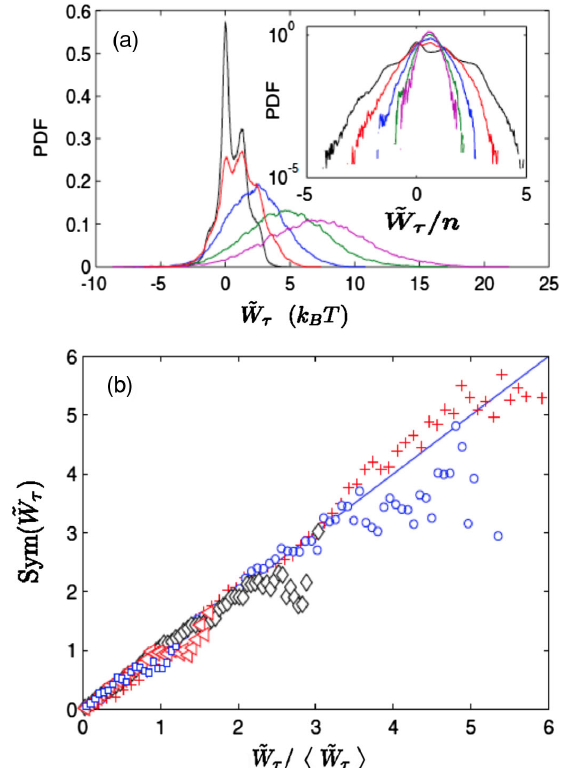
~ W τ for different